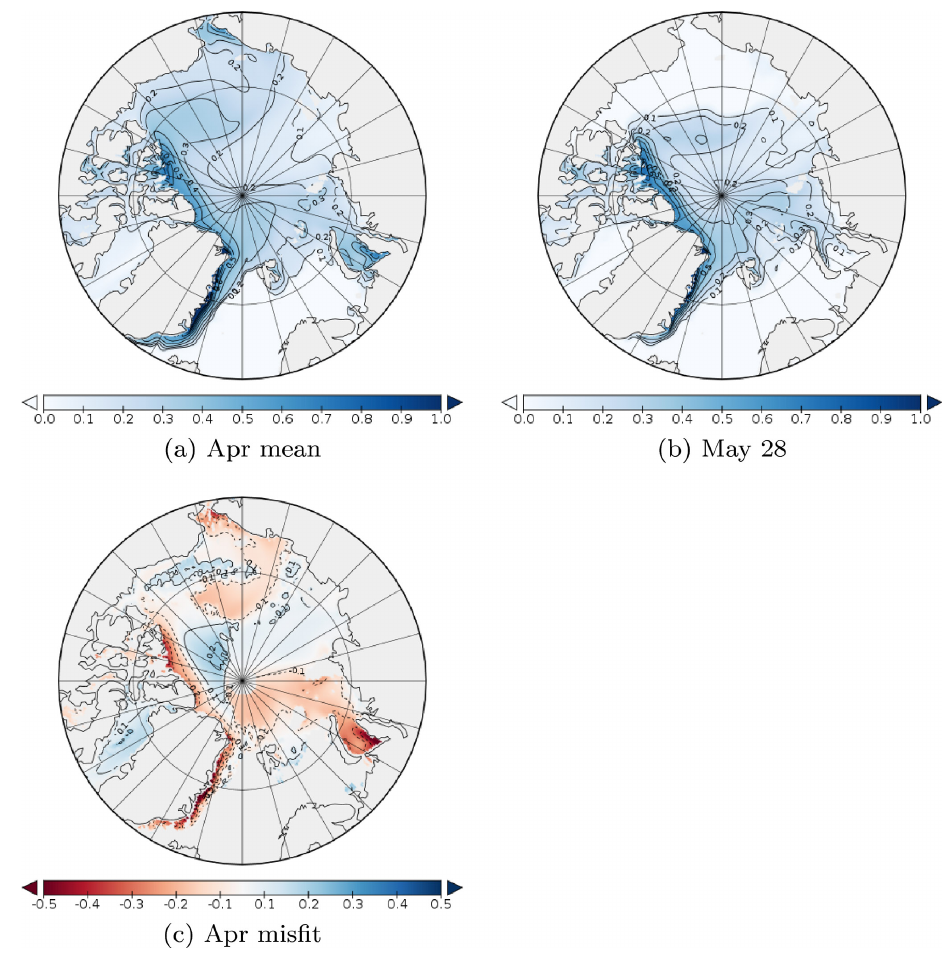
Figure 9. (a) The modelled mean April 2015 snow depth (m), (b) the modelled snow depth on 28 May 2015, and (c) the mean April 2015 misfit of the modelled snow depth relative to the modified Warren climatology used in the CryoSat-2 sea ice thickness retrieval. In panel (c) , shades of red indicate underestimation and shades of blue indicate overestimation of snow depth in the